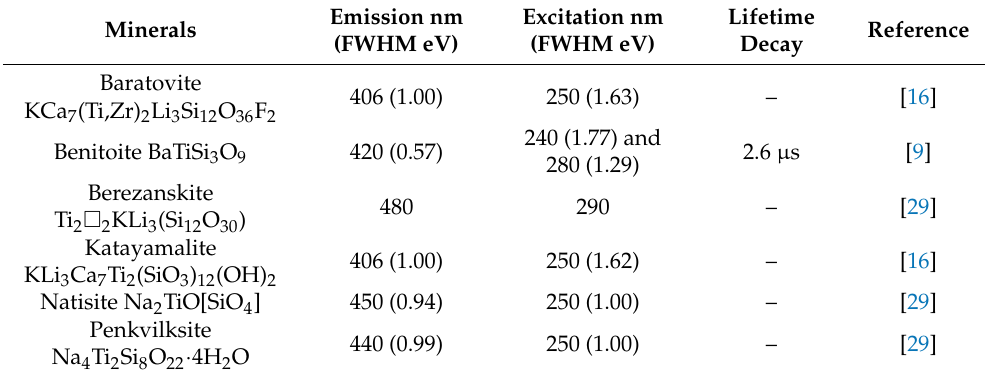
Table 1. Summary of luminescent properties of Ti-bearing natural minerals for which BSL has been documented. For all, the perceived luminescence color is blue and the purported is TiO 6 . Emission nm Excitation nm Lifetime Minerals Reference (FWHM eV) (FWHM eV) Decay Baratovite 406 (1.00) 250 (1.63) – [16] KCa 7 (Ti,Zr) 2 Li 3 Si 12 O 36 F 2 240 (1.77) and Benitoite BaTiSi 3 O 9 420 (0.57) [9] Berezanskite – [29] Ti 2 (cid:3) 2 KLi 3 (Si 12 O 30 ) Katayamalite – [16] Natisite Na 2 TiO[SiO 4 ] 450 (0.94) – [29] Penkvilksite –